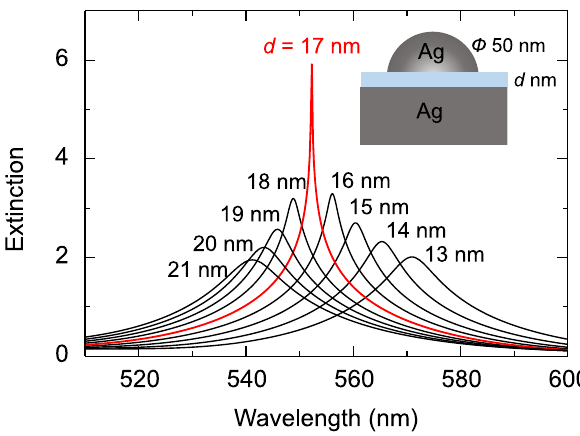
Figure 7: Dependency on the extinction spectra as a function of spacer thickness (from 13 to 21 nm in steps of 1 nm) of the nanohemisphere on mirror (NHoM) structure obtained based on finite difference time domain (FDTD)